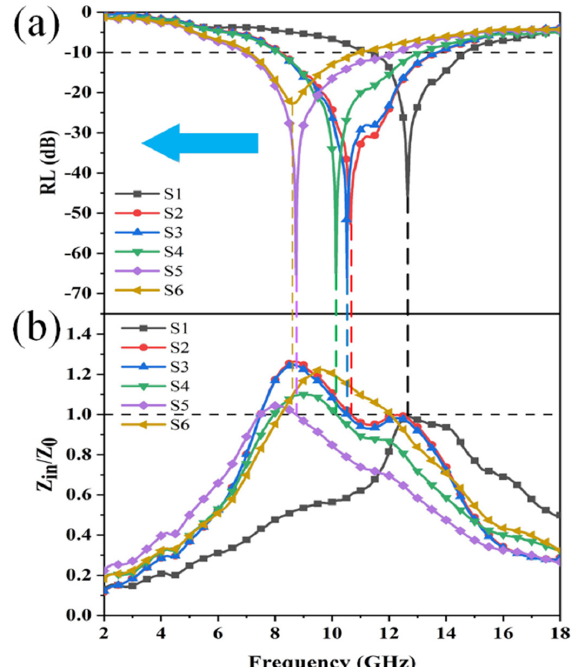
Figure 8. ( a ) RL value of six kinds of three-layer magnetic foam at a thickness of 3.0 mm; ( b ) Z in / Z 0 value of six kinds of three-layer magnetic foam at a thickness of 3.0 mm.